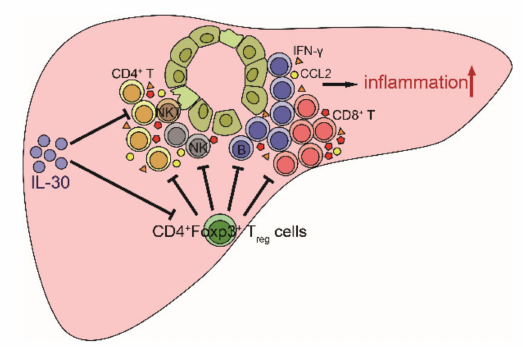
Figure 7. Schematic summary of this study. Infiltrating immune cells such as CD4 + T, CD8 + , NK, NKT, and B cells mediate the destruction of intrahepatic small bile ducts and lead to liver inflammation and fibrosis in PBC. Tregs can suppress various immune cells. IL-30 suppresses the number of infiltrating activated CD4 + T cells. However, IL-30 also decreases the number of immunosuppressive Tregs. Hence, the administration of IL-30 did not suppress, but slightly enhanced, liver inflammation in the murine model of PBC.